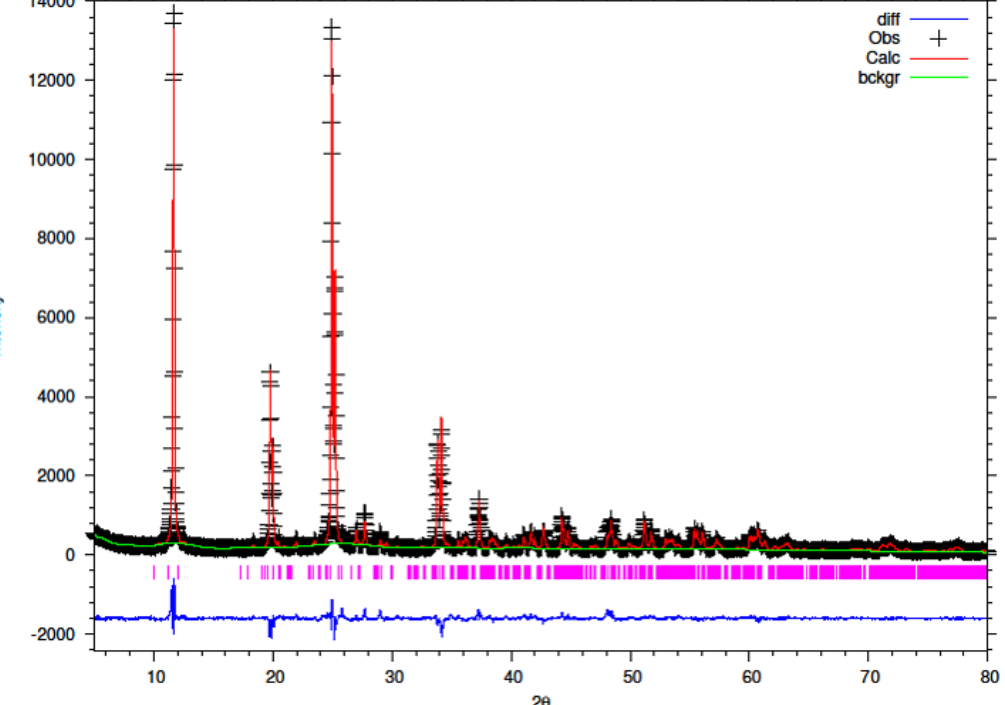
Figure 12. Final observed (cross), calculated (red line) and difference (blue bottom) Rietveld plots for conventionally refluxed 15% Y–ZrP.